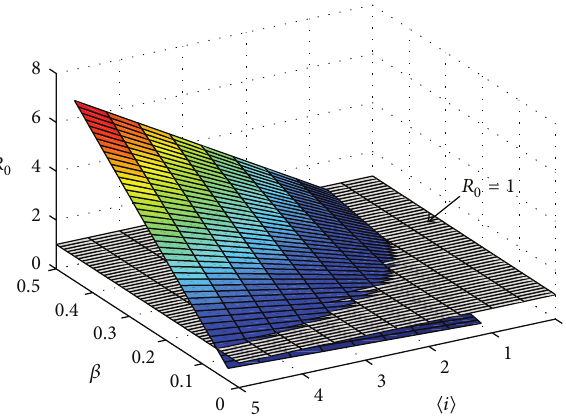
Figure 2: 𝑅 0 as a function of 𝛽 and ⟨𝑖⟩ , which depends on the heterogeneity of the social networks and the diversity of the infectious periods of the